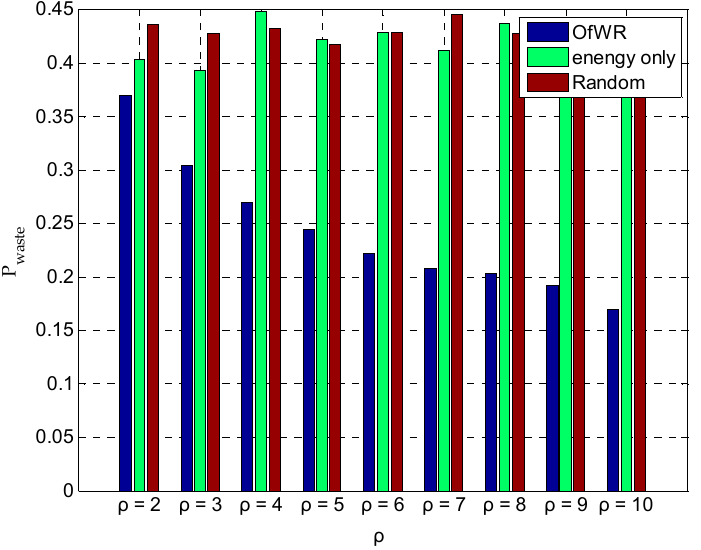
Figure 9. The comparison of the energy waste rate.